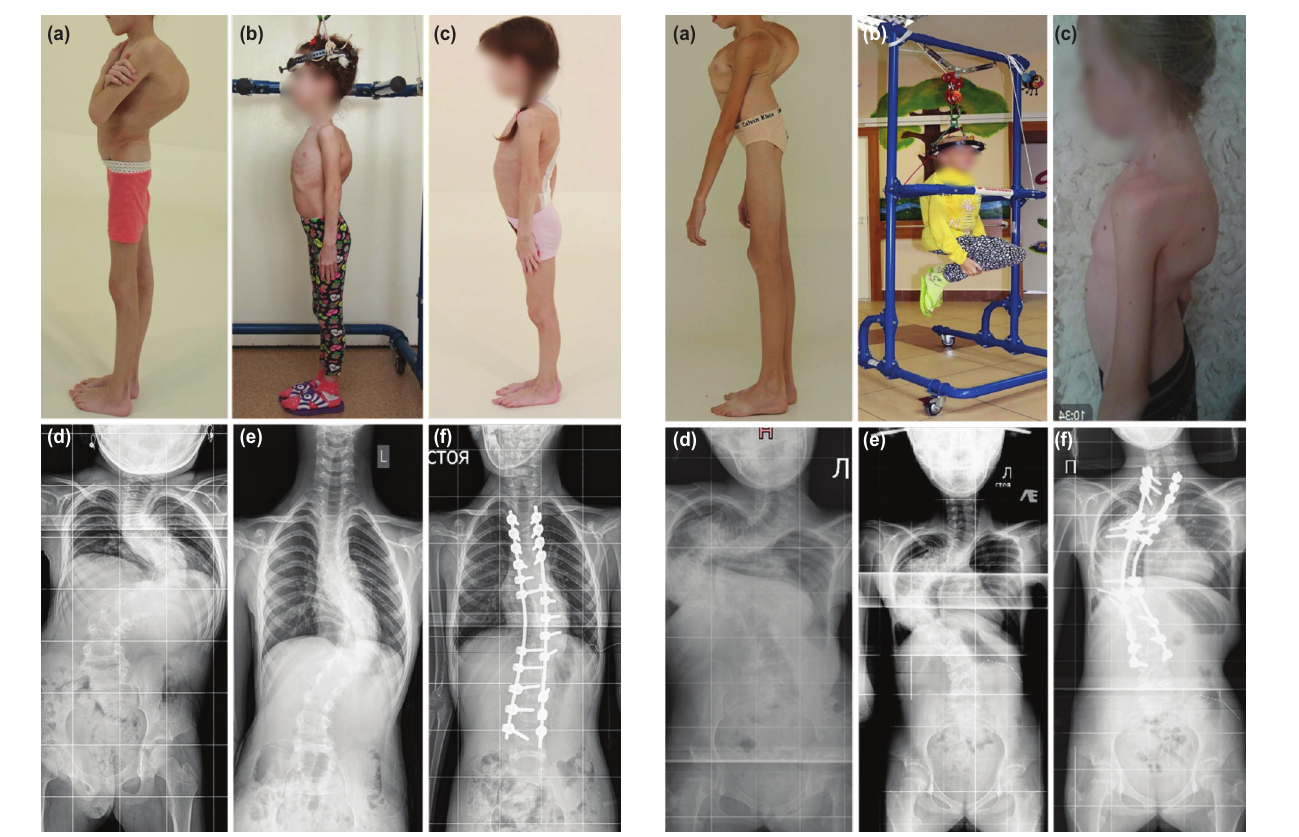
13-year old with Ehlers-Danlos syndrome (Case 2). Fig. 2: Images (a) pre-operative, (b) on traction and (c) post-operative. Radiographs (d) pre-operative, (e) on traction and (f)